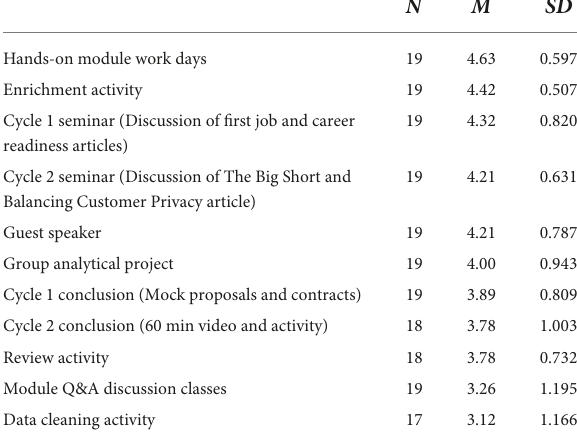
TABLE 6 Student mean ratings of their liking of various course activities (5-point Likert scale, where 5 is “like a great deal” and 1 is “dislike a great